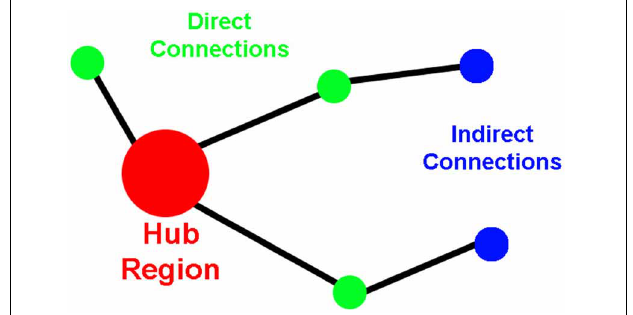
FIGURE 1 | Cartoon demonstrating the properties of the direct and the indirect connections to network